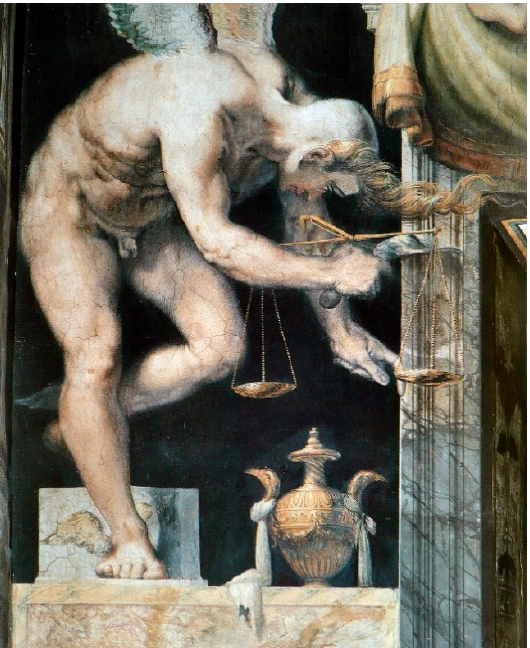
Figure 1. Francesco Salviati (Francesco de’ Rossi) , Kairos . 1552–1554. Palazzo Sacchetti, Rome. Public Domain. Wiki Commons.